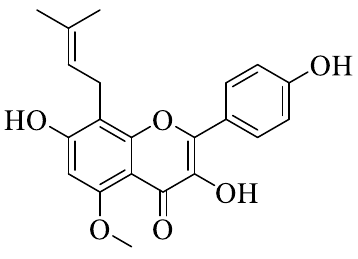
Figure 13. Chemical structure of 46